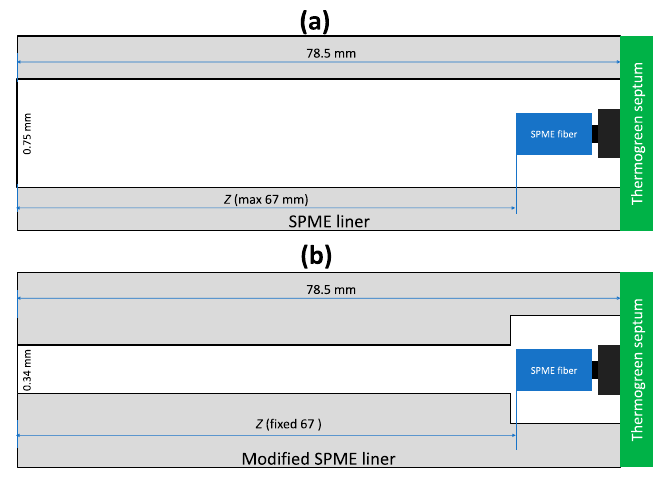
Figure 8. Alternative geometries for TWA SPME sampling: ( a ) used by Tursumbayeva [18], and ( b ) proposed in this research to minimize sources of deviation from Fick’s law of diffusion calibration.